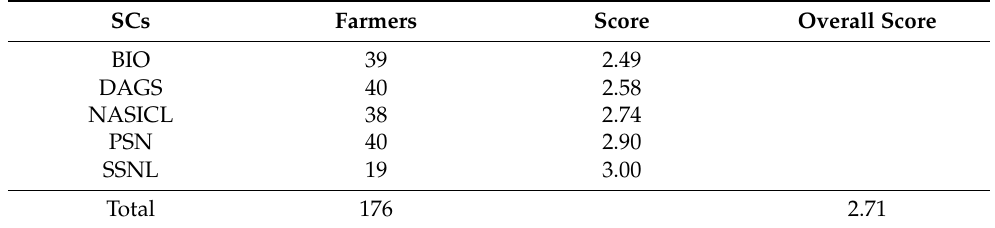
Table 5. Results of training